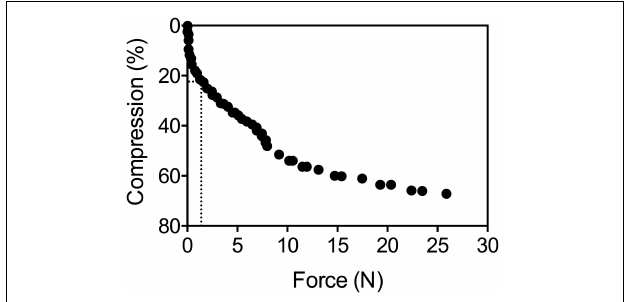
FIGURE 1 | Raw data of the compression (%) of one root under an increasing mechanical pressure (N). The dotted lines show that a force of 1.3N corresponds with a 22% change in root